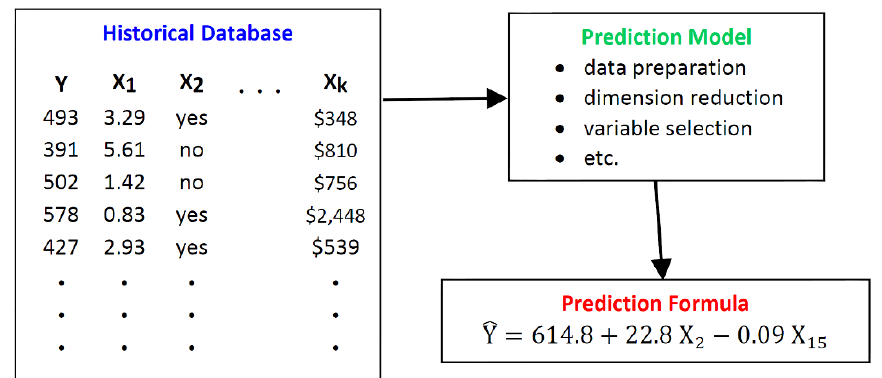
Figure 1. The development